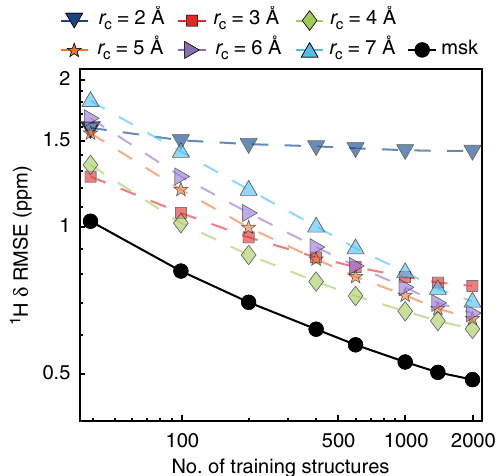
Fig. 2 1 H chemical shift prediction error of the trained model for the CSD- 500 set. The RMSE prediction error between chemical shifts calculated with ShiftML and GIPAW DFT is shown for different local environment cut- off radii, and for the multi-kernel (labeled as msk), as a function of the training set